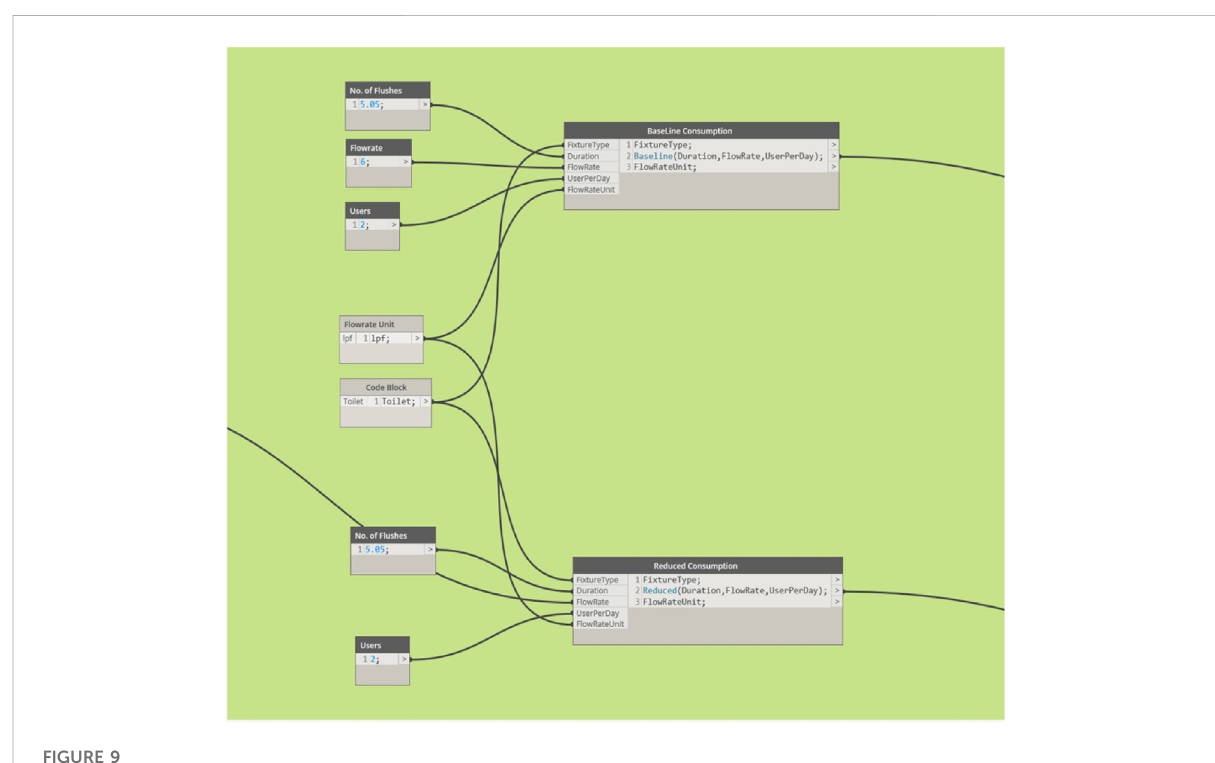
FIGURE 9 Detailed view of the toilet script (Part